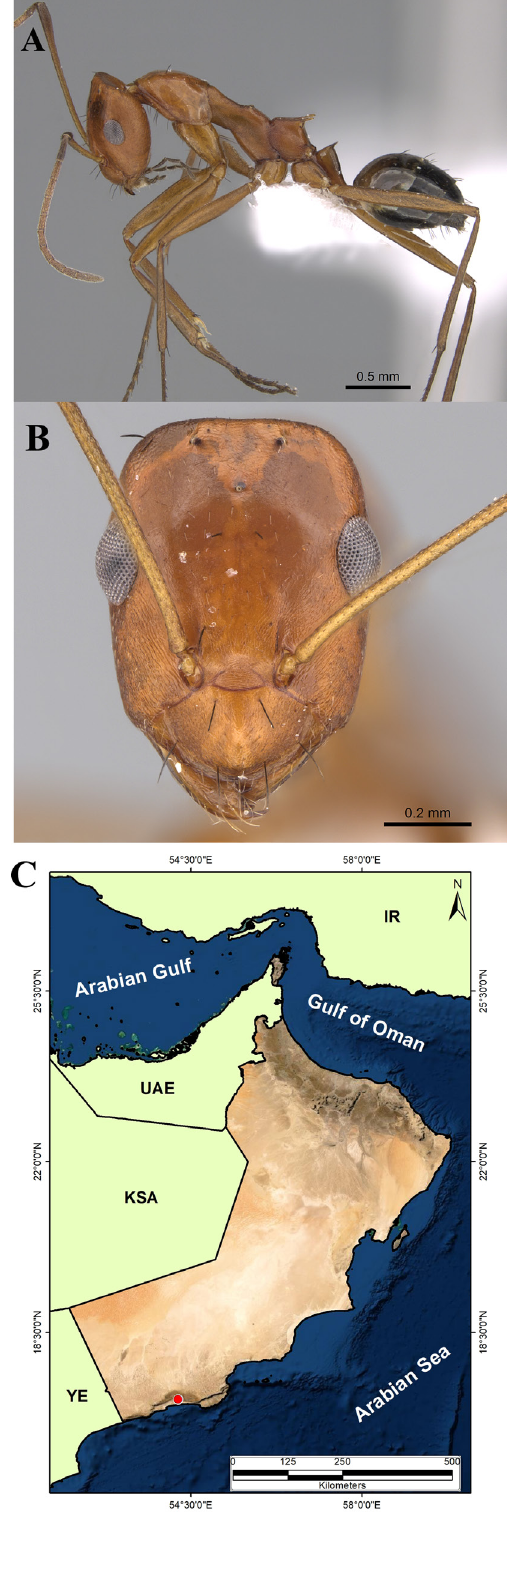
Fig. 18. Lepisiota elbazi Sharaf & Hita Garcia, 2020, paratype, worker (CASENT0922860, AntWeb.org (Michele Esposito)). A . Body in profile. B . Head in full-face view. C . Distribution